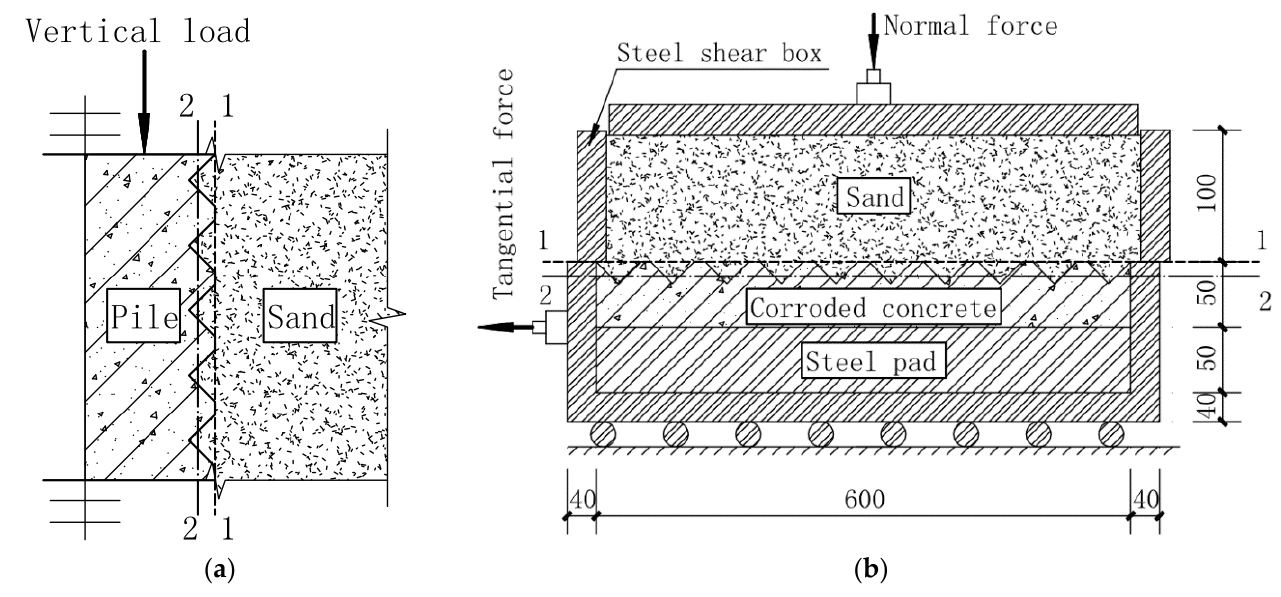
Figure 6. Schematic diagram of interface location selection of the interface between sand and corroded concrete. ( a ) Corroded pile and soil; ( b ) Soil and concrete specimen placed in the shear box.